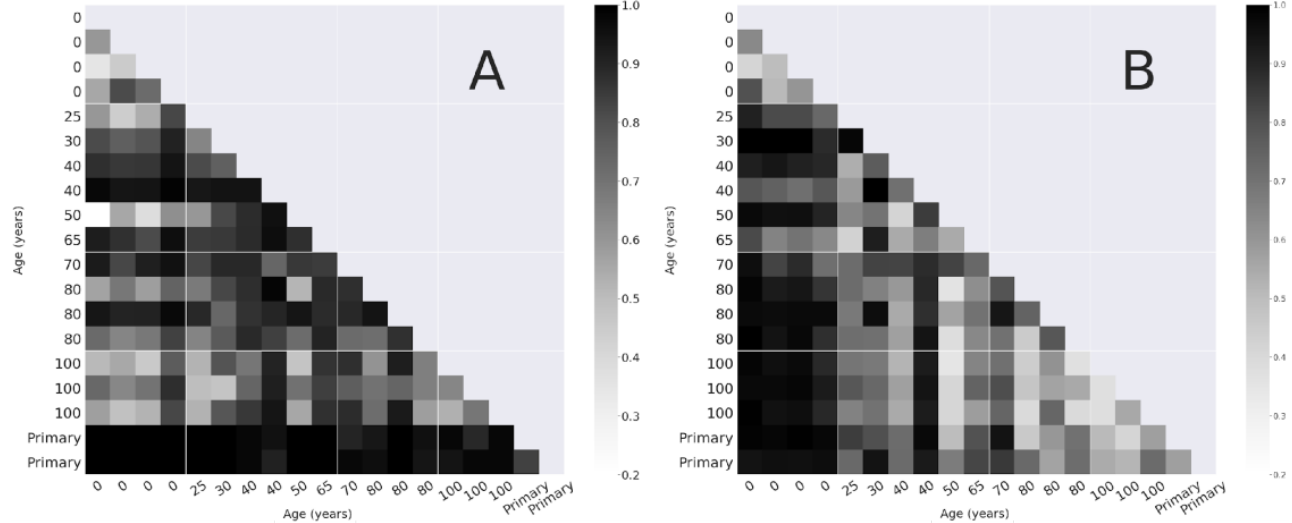
Figure 4. Pairwise Bray Curtis dissimilarity between sites based on the field surveys ( A ), and remote sensing ( B ) sorted by regeneration time.